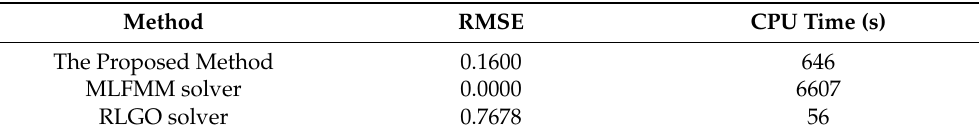
Table 1. The RMSE and CPU time of different methods.